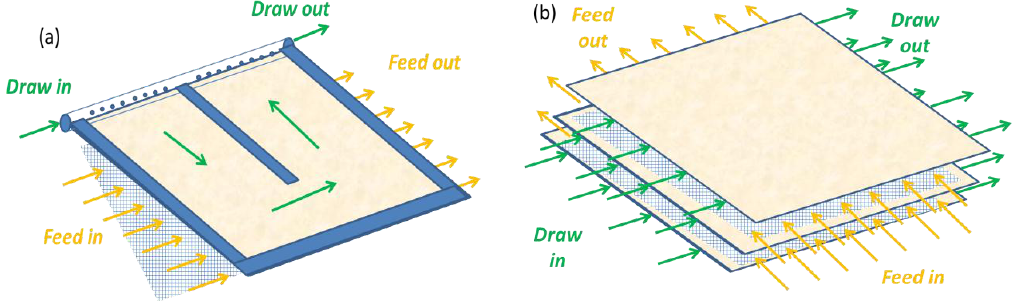
Figure 6. Illustrations of flat-sheet FO membranes arranged in ( a ) spiral wound and ( b ) plate and frame modules design.